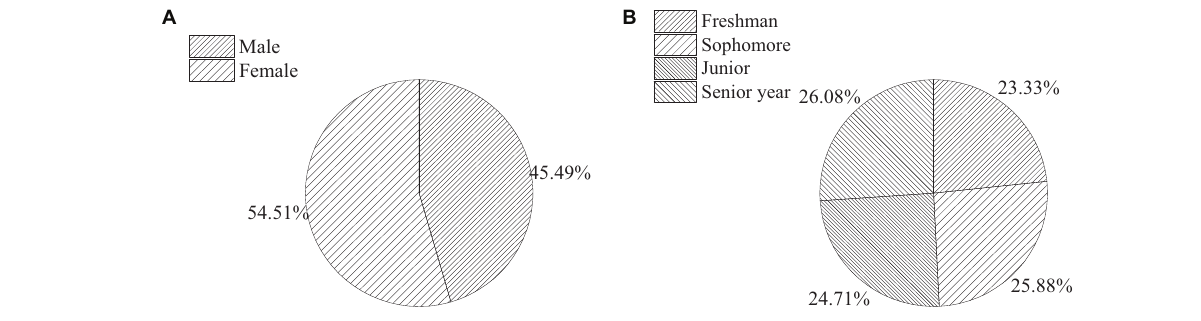
FIGURE 2 | Basic information of the respondents [ (A) the ratio of gender; (B) the ratio of grade].